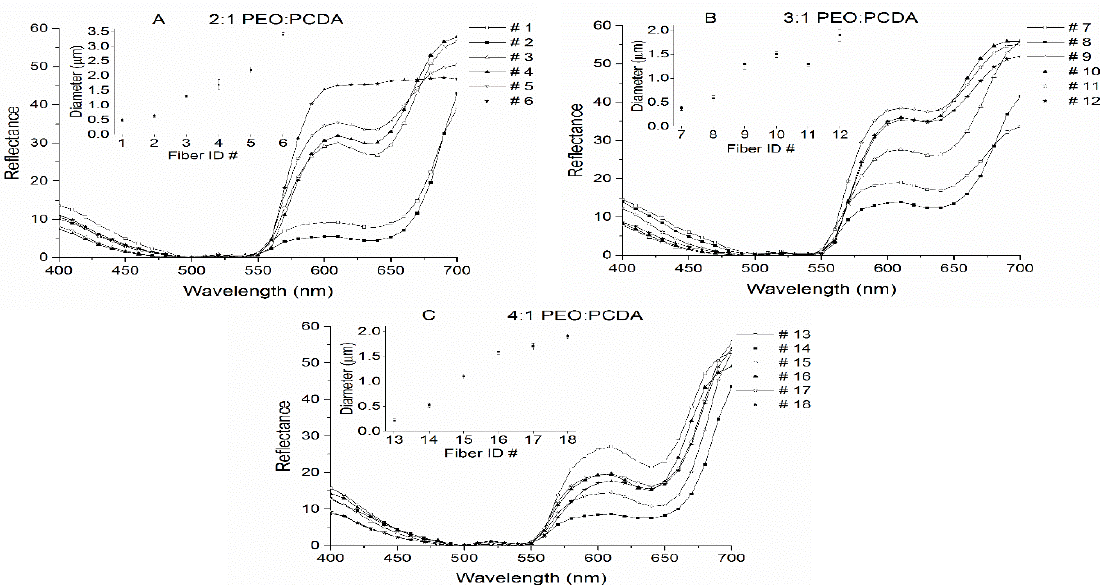
Figure 5. Normalized reflectance spectra of 18 fibers that were heated at 70 °C for 10 minutes. ( A ): Fibers #1–#6 have mass ratio of PEO to PCDA of 2:1; ( B ): Fibers #7–#12 have mass ratio of PEO to PCDA of 3:1; ( C ): Fibers #13–#18 have mass ratio of PEO to PCDA of 4:1. The inserted figures show the diameters of the corresponding fibers. Fibers #1–#6 exhibit a more pronounced reflectance switch from blue to red.